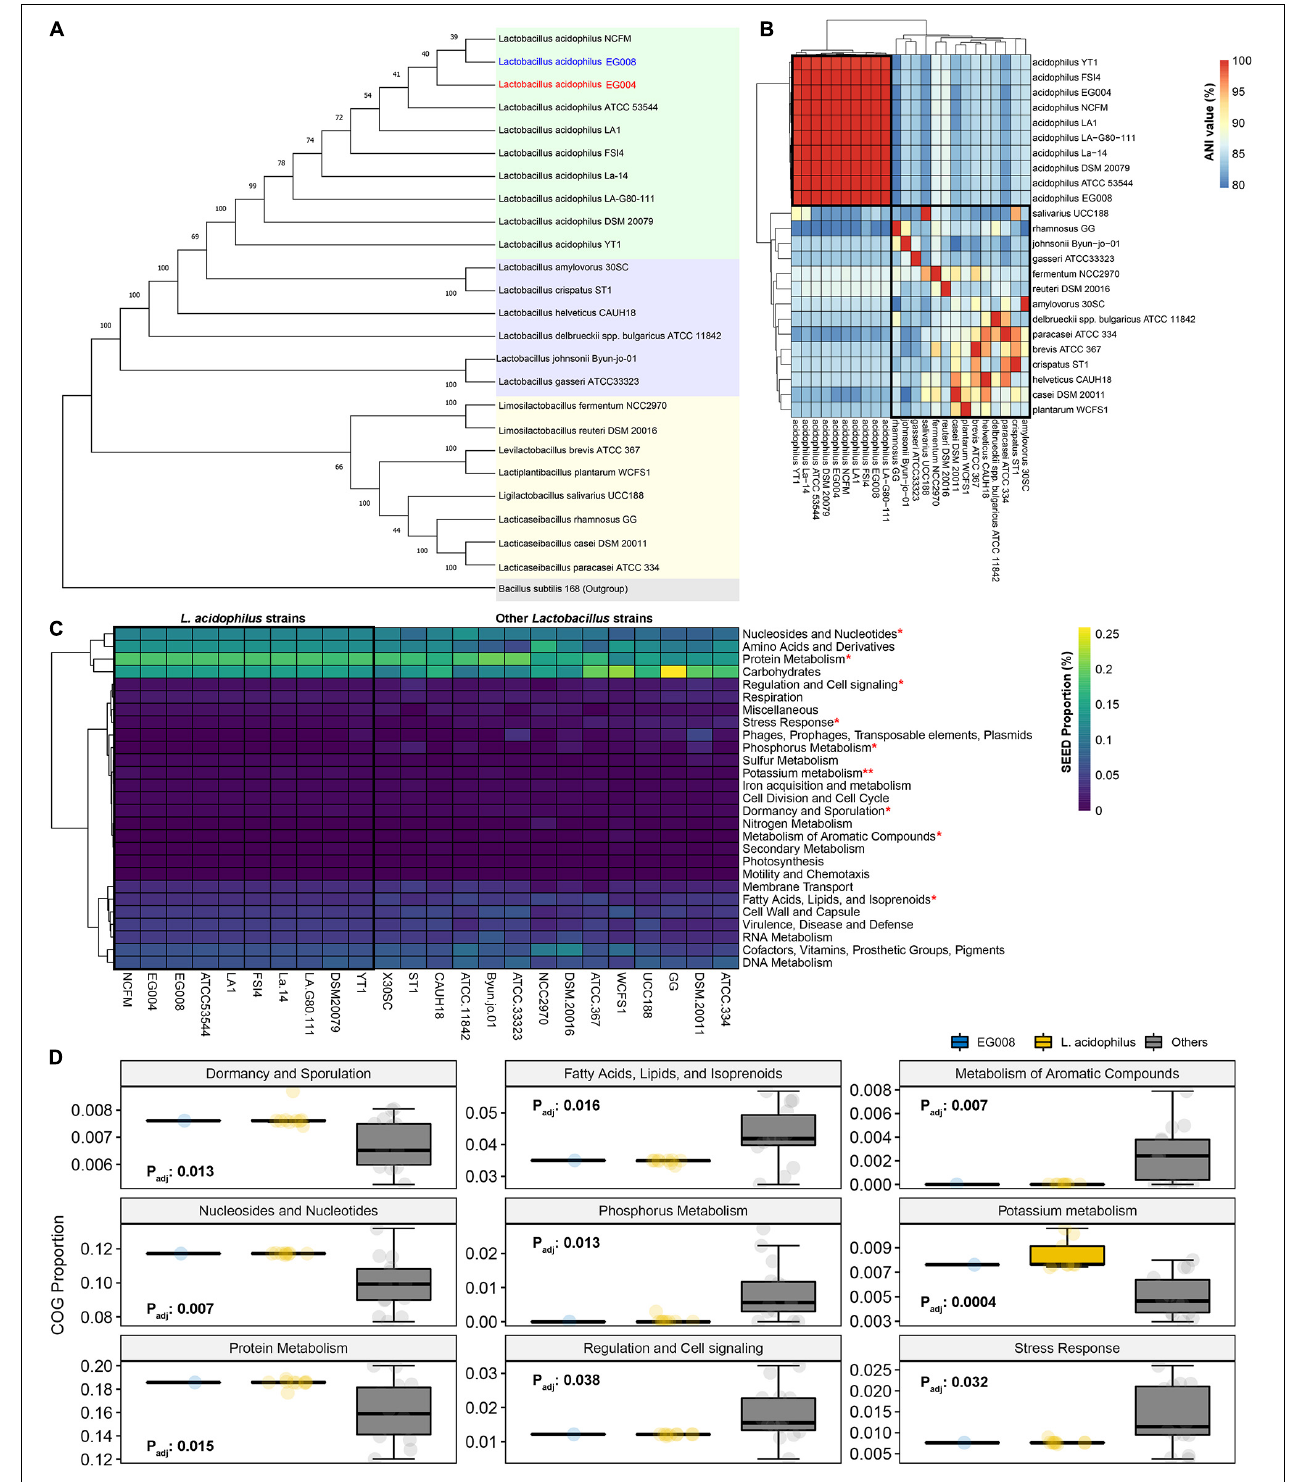
FIGURE 3 | A comparative genome analysis for Lactobacillaceae based on the complete genome sequence of the newly developed L. acidophilus strain. (A) Neighbor-joining tree based on 16S rRNA sequences for 24 Lactobacillaceae families including the strain newly developed in this study. Bootstrapping was performed 1,000 times, and Bacillus subtilis 168 was considered as an outgroup. (B) Hierarchical clustering results based on average nucleotide identity among 24 Lactobacillaceae families. (C) A comparison of predictive SEED ratios between 24 Lactobacillaceae strains. (D) SEEDs with statistically significant differences between L. acidophilus and the rest of the Lactobacillaceae strains at 5% significance level after multiple testing adjustments. * P < 0.01 and ** P < 0.001 in comparison of L. acidophilus and other strains.